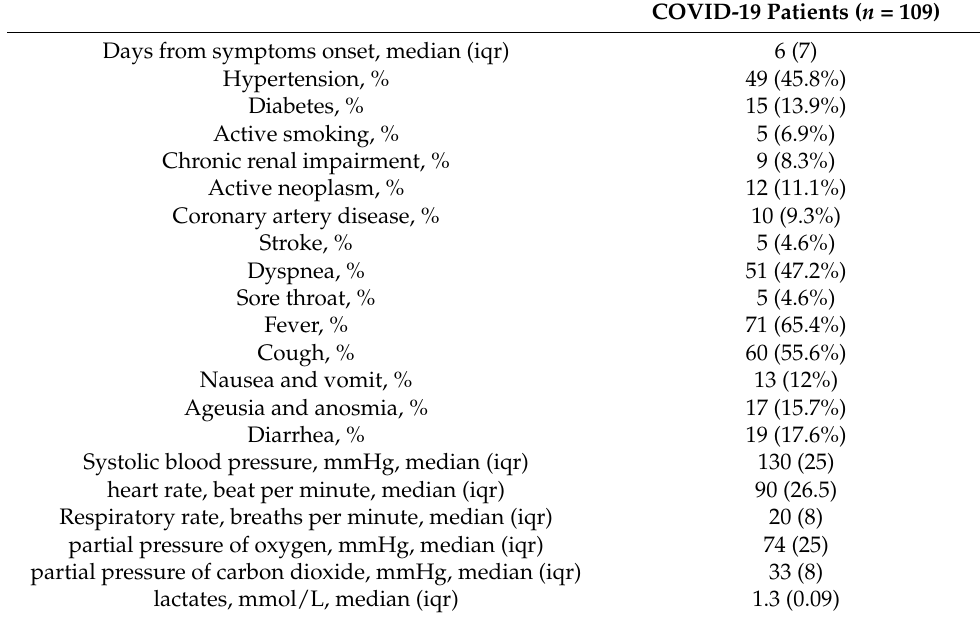
Table 1. Demographic characteristics and symptoms as reported at Emergency Department